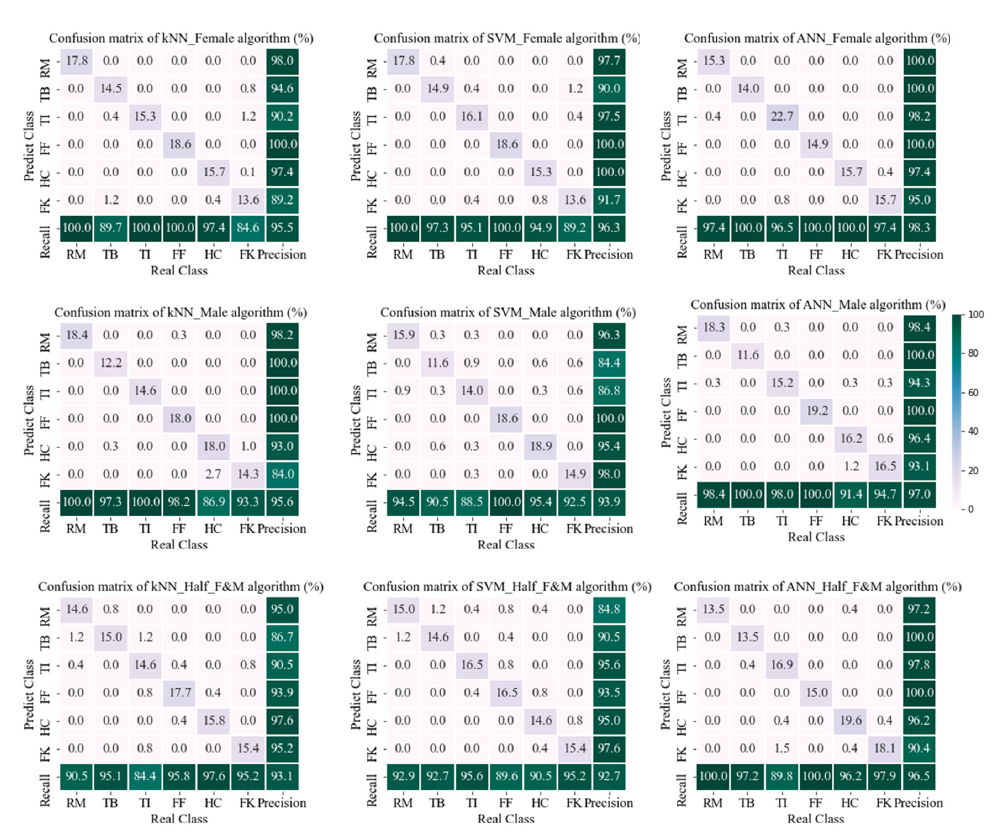
Figure 3. Three classifiers (kNN, SVM and ANN) were applied to the confusion matrix (7 × 7) gen- erated by differentiating-the-sex dataset method for test-set hand gesture recognition. Precision rep- resents the prediction accuracy of each gesture, and Recall represents the predicted coverage of each gesture. Precision = (cid:2904)(cid:2900) × 100% Recall = (cid:2904)(cid:2900) × 100% where TP = true positive; FP = false posi- (cid:2904)(cid:2900)(cid:2878)(cid:2890)(cid:2900) (cid:2904)(cid:2900)(cid:2878)(cid:2890)(cid:2898) tive; and FN = false negative.